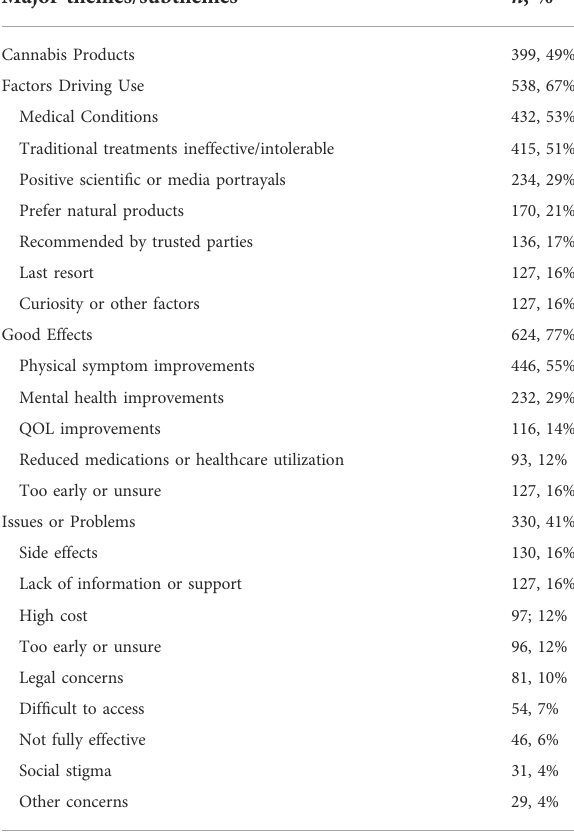
TABLE 2 Major themes and subthemes identi fi ed from participants ’ open-endedresponsesandobservedprevalenceamongthestudy sample ( N =